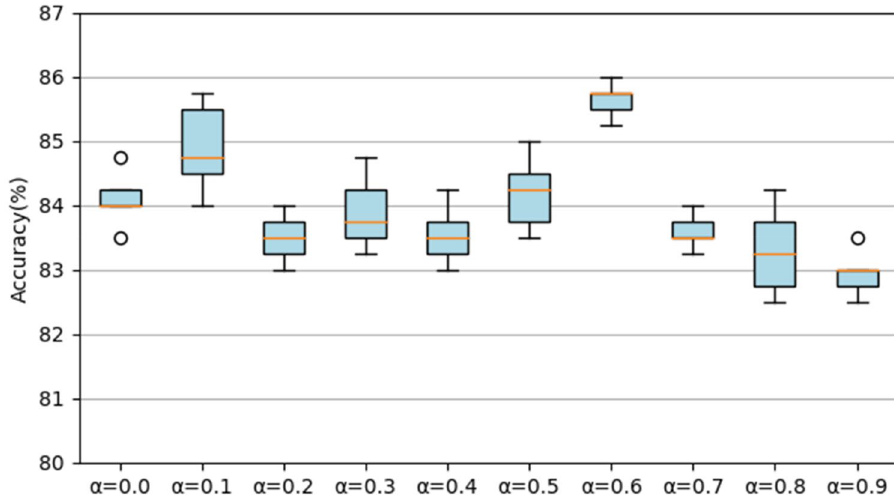
Figure 14. The accuracy of the RACNN model on the ESC-50 dataset under different α .